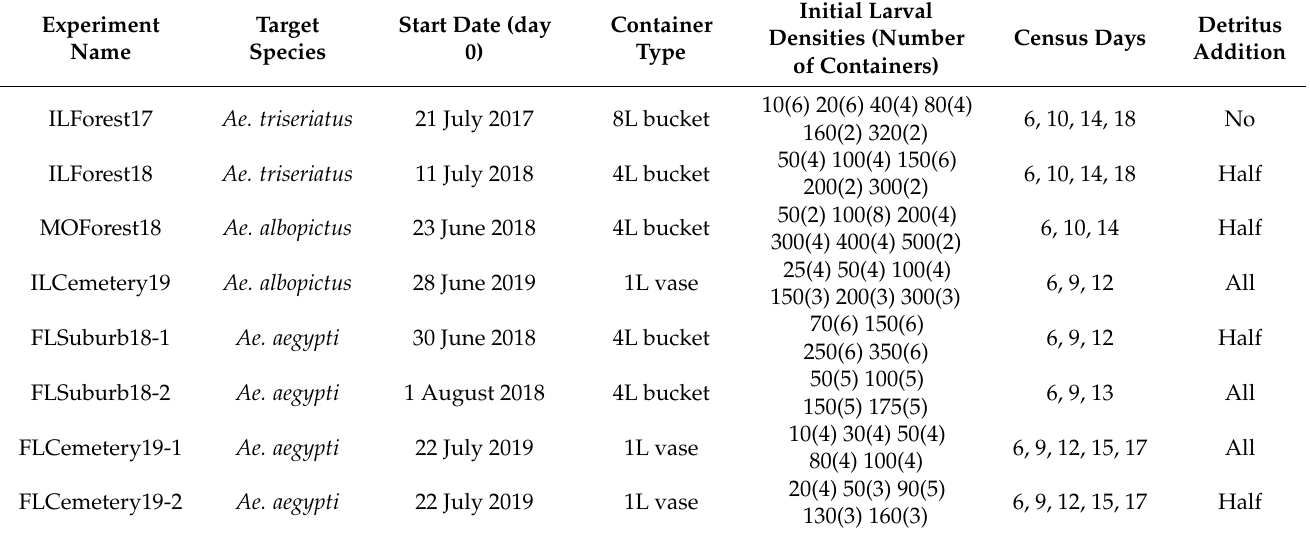
Table 2. Methods for density manipulation experiments. The variation in procedures among experi- ments for the density manipulations are outlined above. The experiments are grouped by the target species. Detritus additions are from secondary containers to supplement resources throughout the experiment. “Half” indicates that half of the containers received detritus additions. Census days are relative to the start